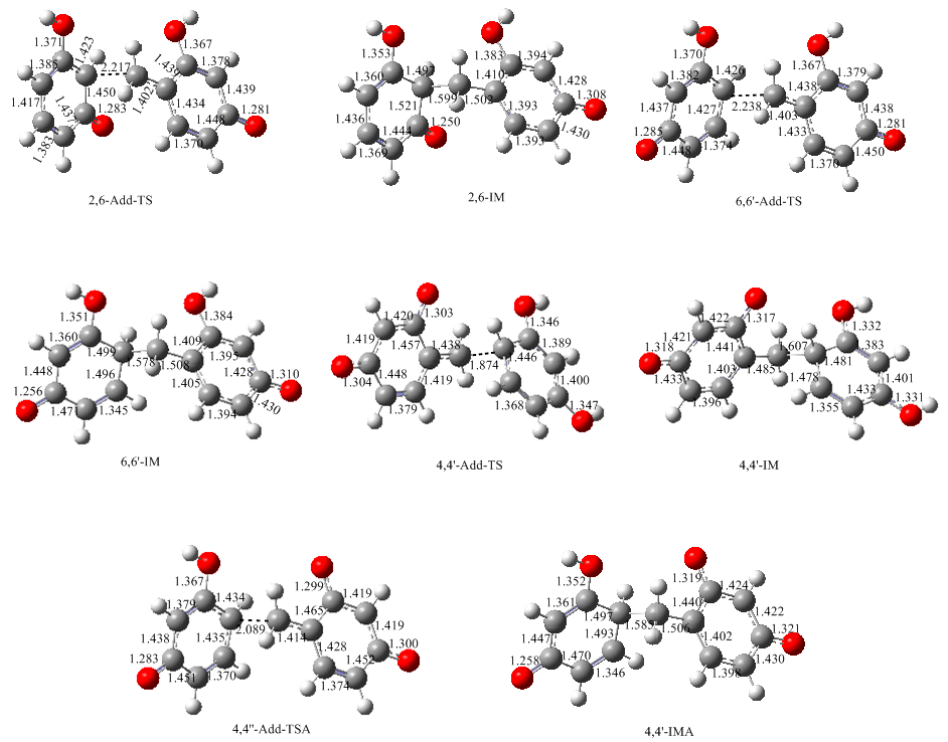
Figure 11. The calculated structures of transition states and product-like intermediates for the Michael addition reactions in Figure 10.